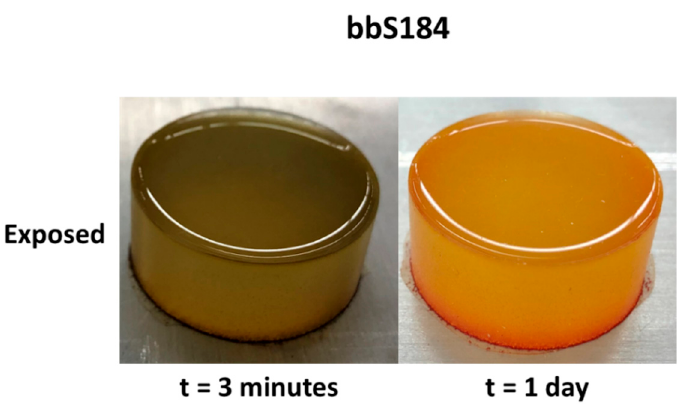
Figure 3. The temporal change of bbS184 one day after exposure.